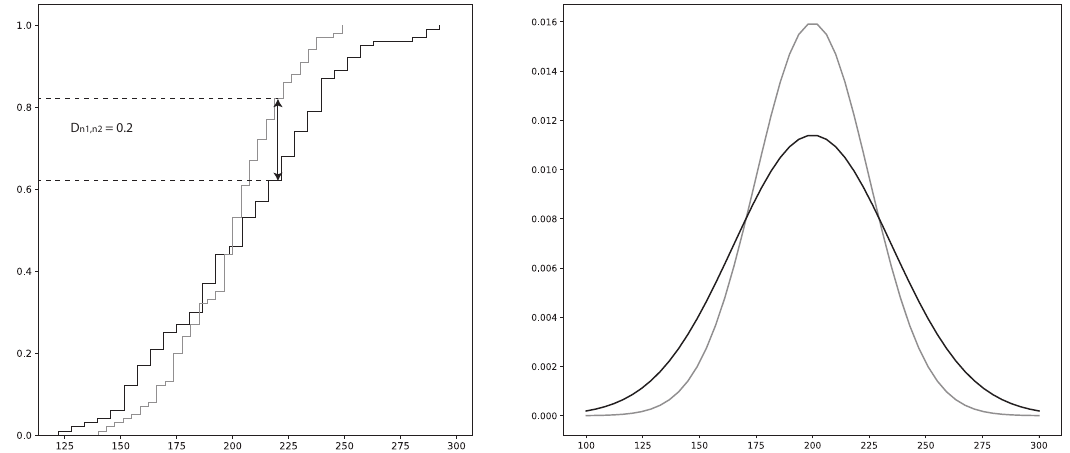
Figure 3. The two-sample Kolmogorov–Smirnov (KS)-test illustrated for the random variables X and Y, where X ∼ Norm ( 200,25 ) and Y ∼ Norm ( 200,35 ) [66]. Left: The cumulative distribution functions (CDF) of X and Y. D n , calculated using Equation (5), is shown as the difference between the upper 1 , n 2 and lower dashed lines; 100 samples were drawn from each distribution. Right: The probability density functions of X and Y.